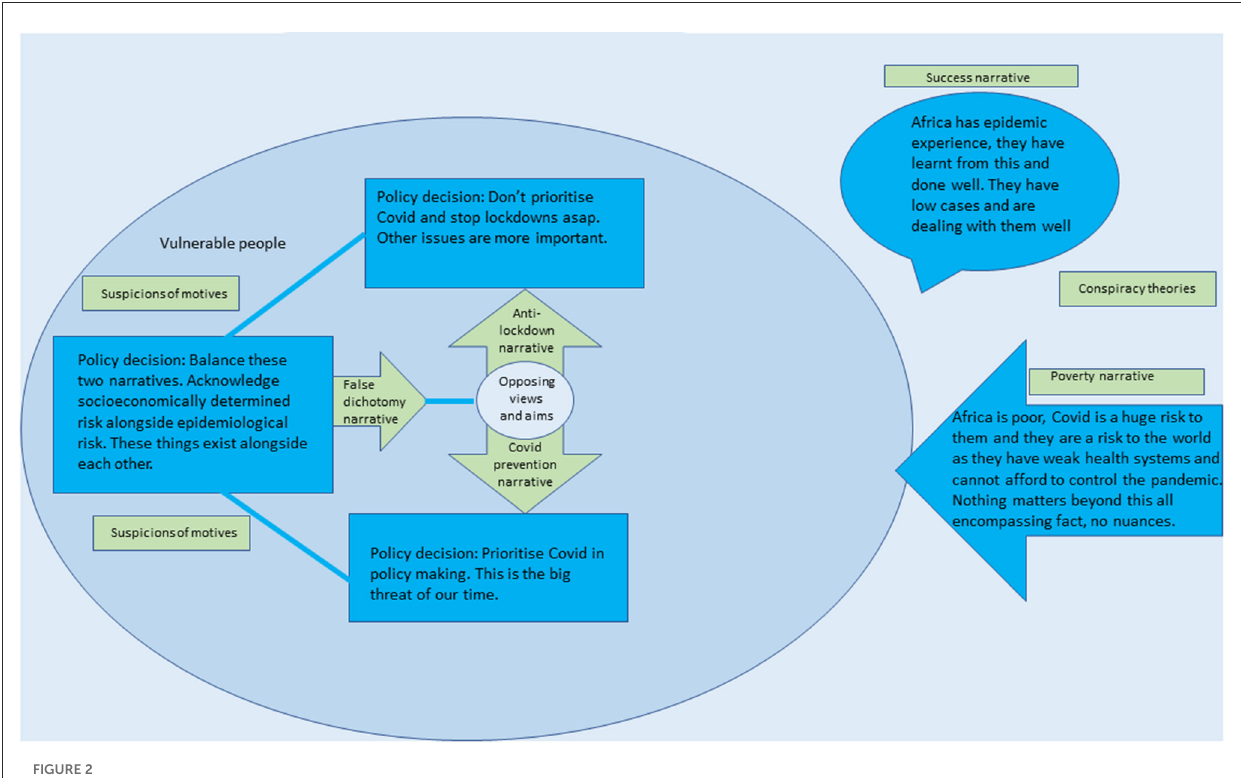
FIGURE2 Six key